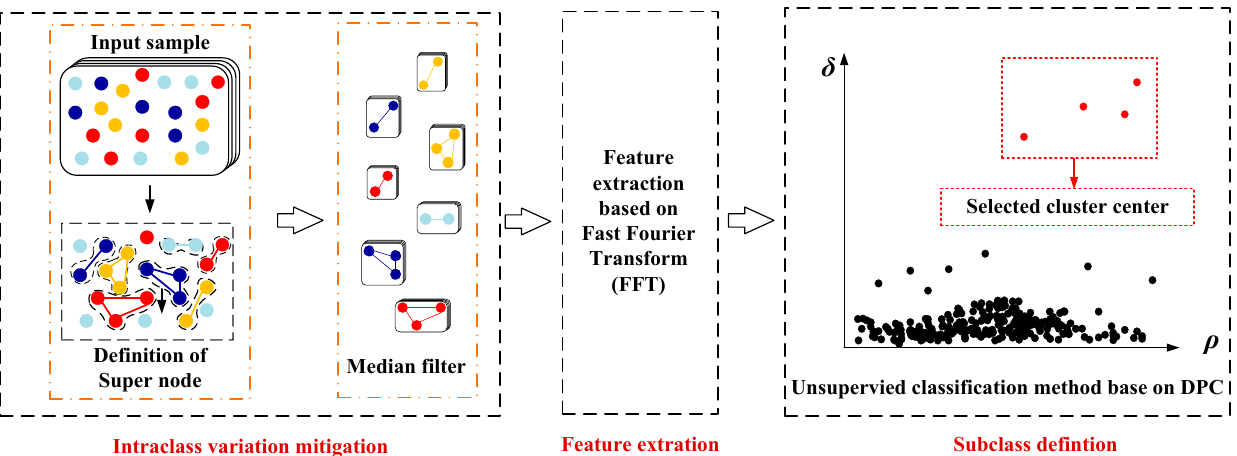
Figure 9. The flow chart of the proposed unsupervised subclass definition method.